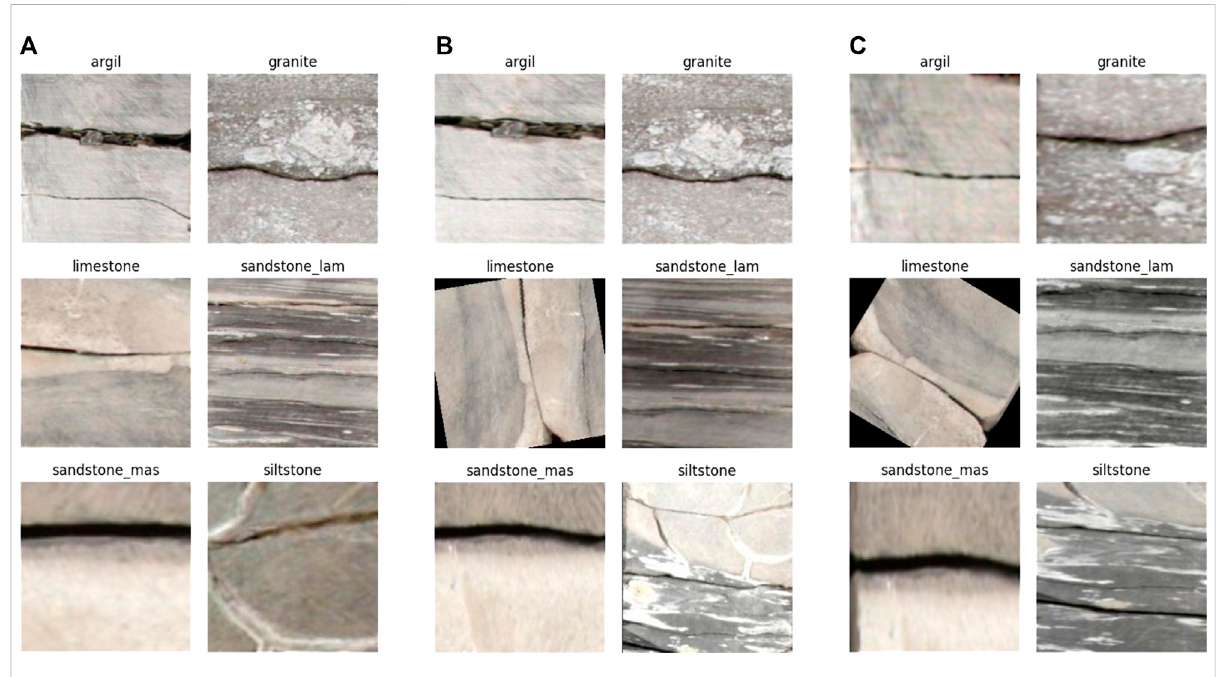
Figure 1 depicts examples of the developed data